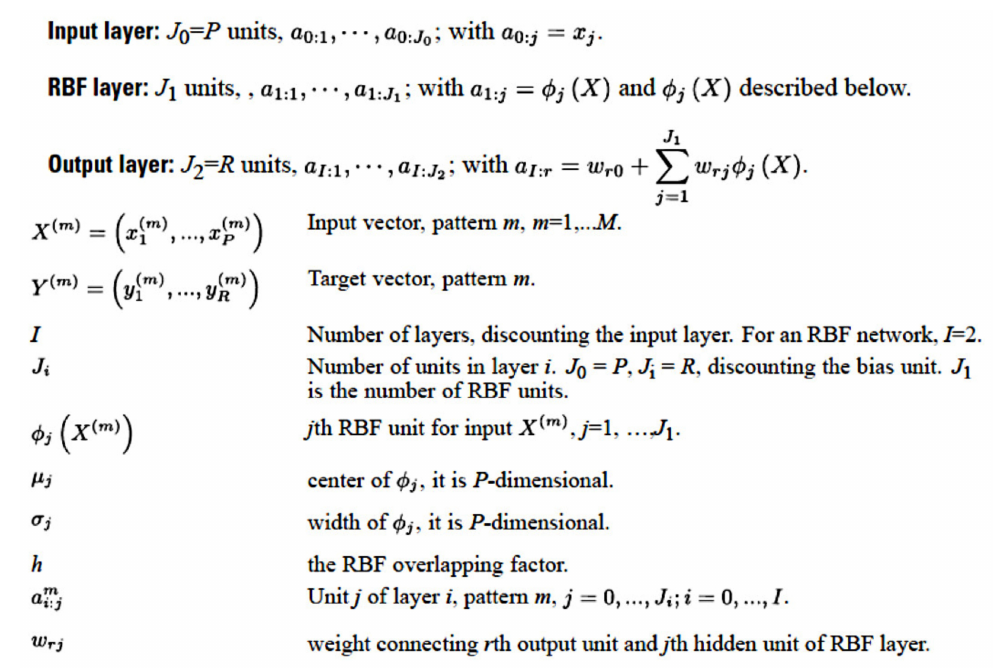
Figure 4. Architecture of the radial basis function (RBF). The RBF is a supervised feedforward learning network that is characterized by only one hidden layer. This figure shows the architecture of the three layers of the RBF network and the corresponding